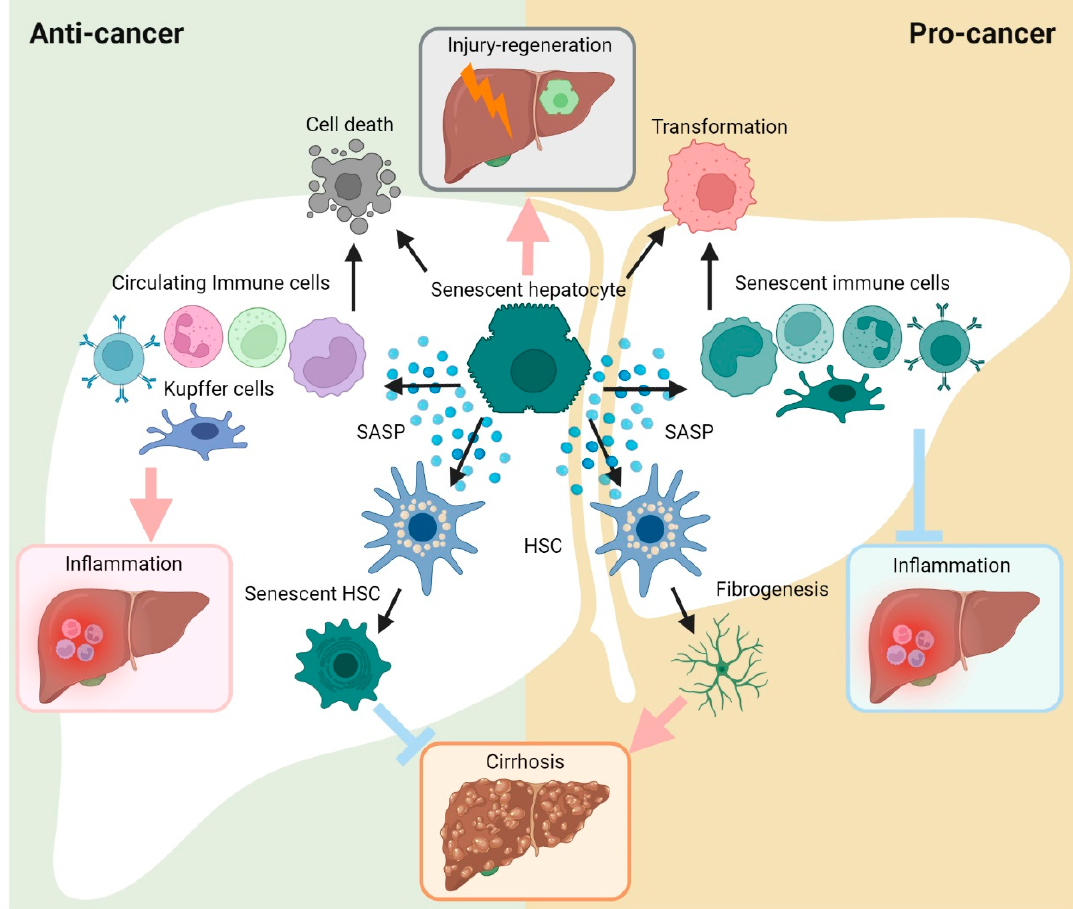
Figure 3. Diverse roles for cellular senescence in hepatocarcinogenesis. The cellular senescence triggered in hepatic cells can arrest cell-cycle progression, subsequently leading to multiple phenotypical alterations. On the one hand, senescent cells can undergo cell death or initiate more active cell proliferation (cancer transformation). On the other hand, the exuberant SASP contributes to modulation of the inflammation and fibrogenesis/cirrhosis. Ultimately, cellular senescence plays as a ‘double agent’ in hepatocarcinogenesis.